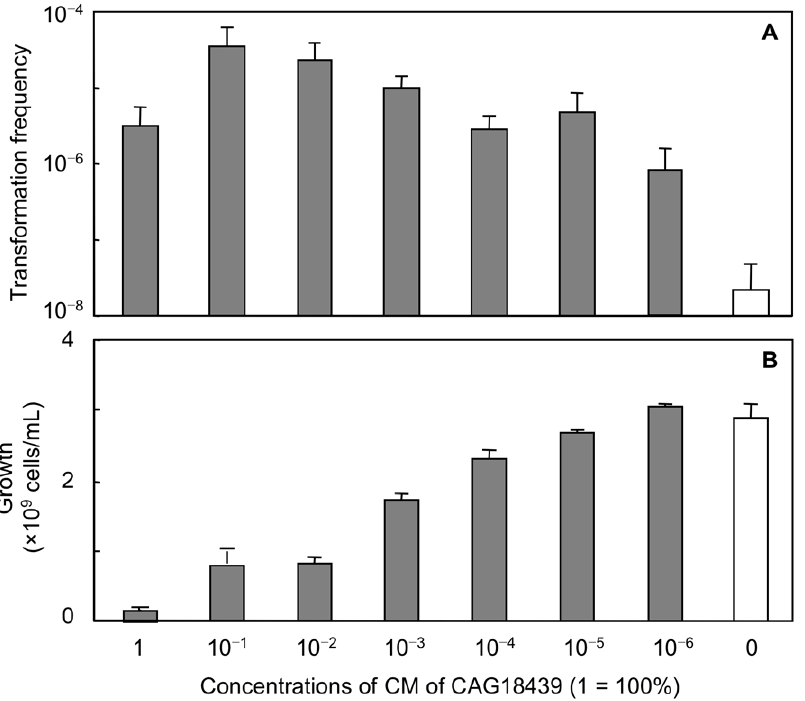
Figure 6. Effects of dilution of CM of CAG18439 on cell-to-cell transformation and cell growth. Effects of dilution of CM of CAG18439 on cell-to-cell transformation (A) and cell growth (B). Co-culture of MG1655 harbouring pHSG299 and MC4100 was performed in the presence of CM. Data are presented as mean and S.D. ( n =3).